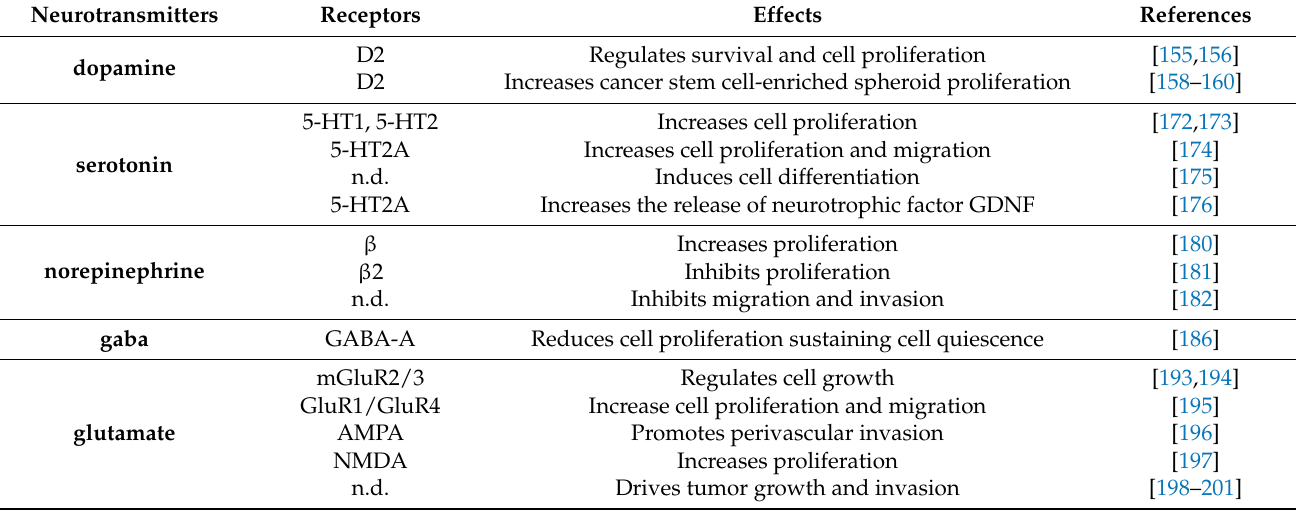
Table 3. Neurotransmitters influence